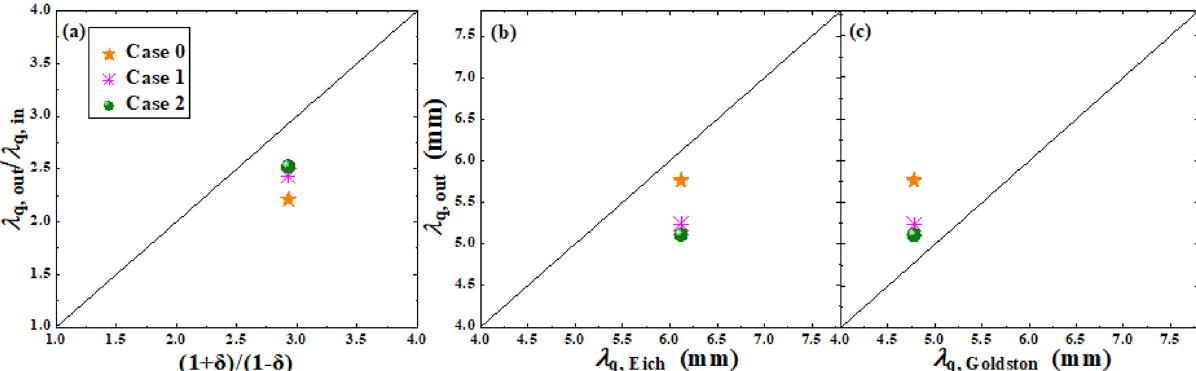
Figure 11. ( a ) The ratio of the outer (cid:31) q to the inner one for the simulation case with all drifts under normal toroidal magnetic field, versus the value predicted by the Goldston’s model. ( b ) and ( c ): the (cid:31) q at the outer target in the case with all drifts under normal toroidal magnetic field, versus the (cid:31) q predicted by Eich’s multi-machine scaling and Goldston’s drift-based